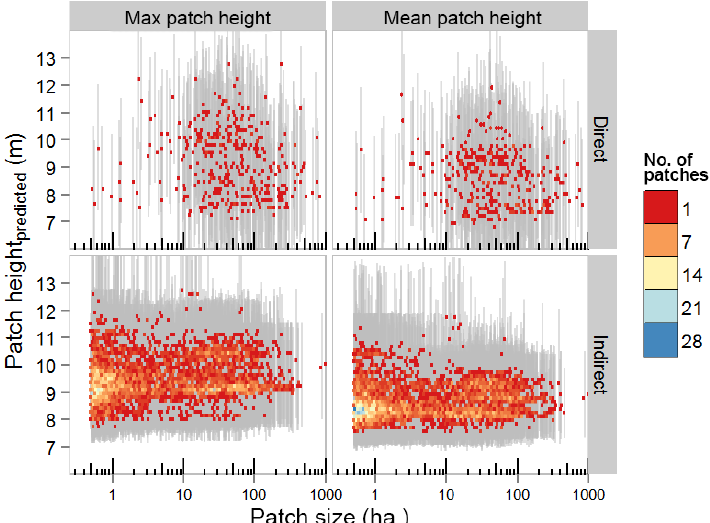
Figure 7. (a) Patch height and 95% prediction intervals (grey lines) for patches from direct prediction and indirect prediction shown across the continuum of patch sizes. (b) Distributions of relative prediction error (95% prediction interval) for patch height